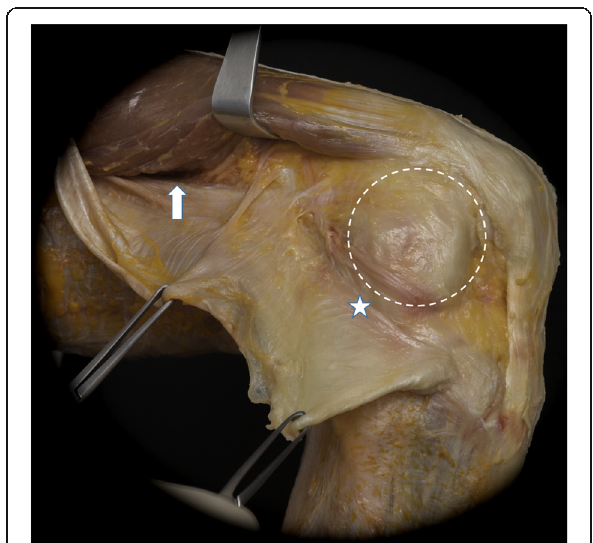
Fig. 4 An anatomic dissection of the lateral aspect of a right knee, with the iliotibial band (ITB) cut and reflected posteriorly (within clamps). The Kaplan fibers (arrow) can be seen running from the superficial ITB, which play a role in rotatory knee stability. The posterior fibers of the ITB (star) blend with the capsulo-osseous layer and the deep ITB to insert on Gerdy ’ s tubercle. The lateral knee capsule (dotted circle) is also